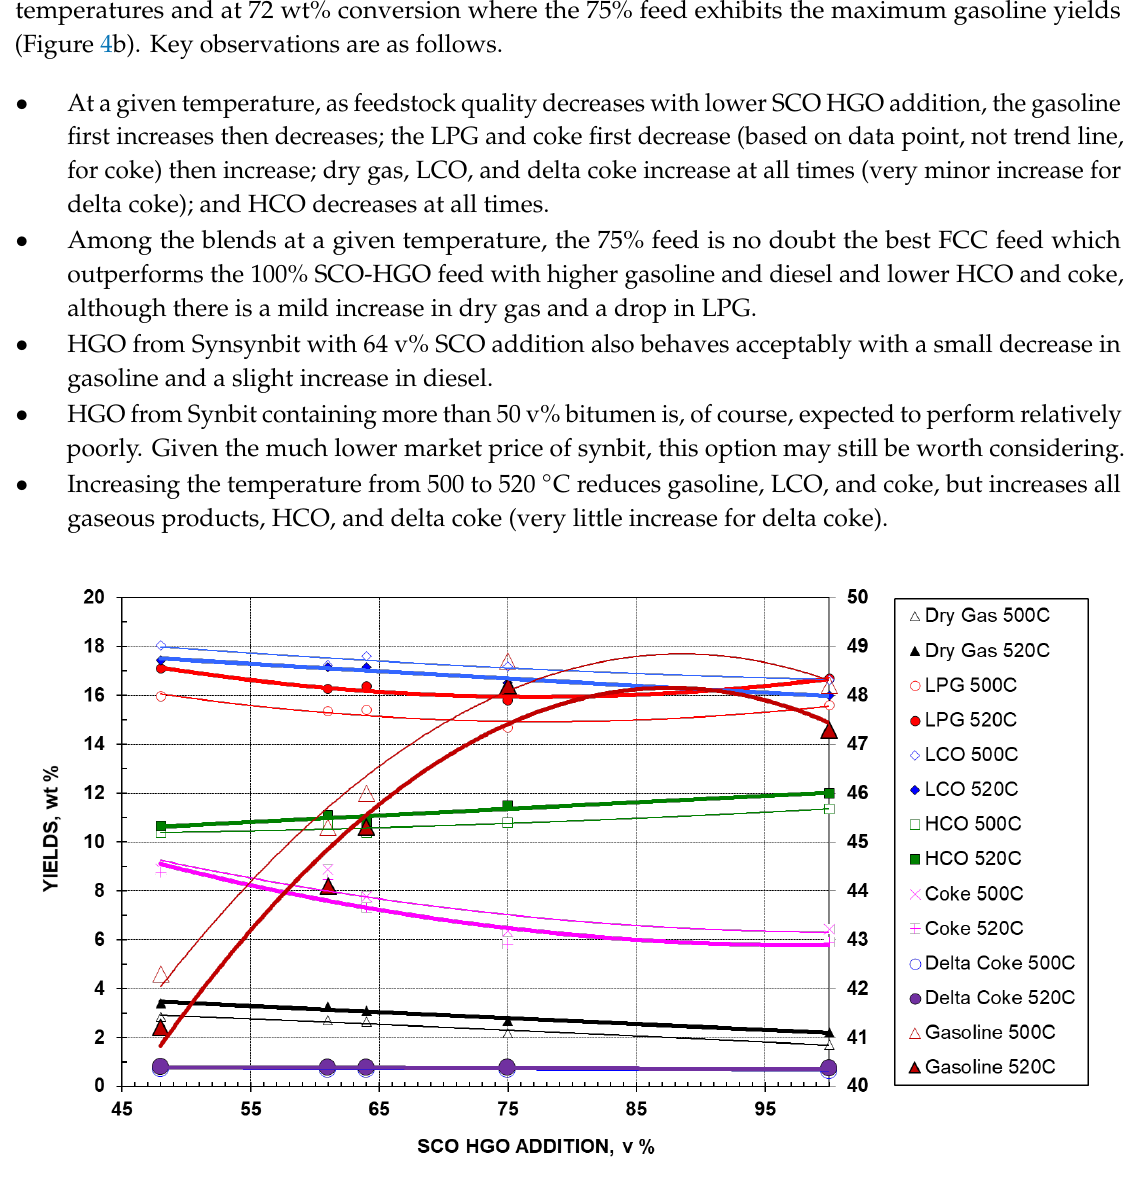
Figure 8. Effect of SCO HGO addition on product yields at 500 and 520 °C. Figure 8. E ff ect of SCO HGO addition on product yields at 500 and 520 ◦